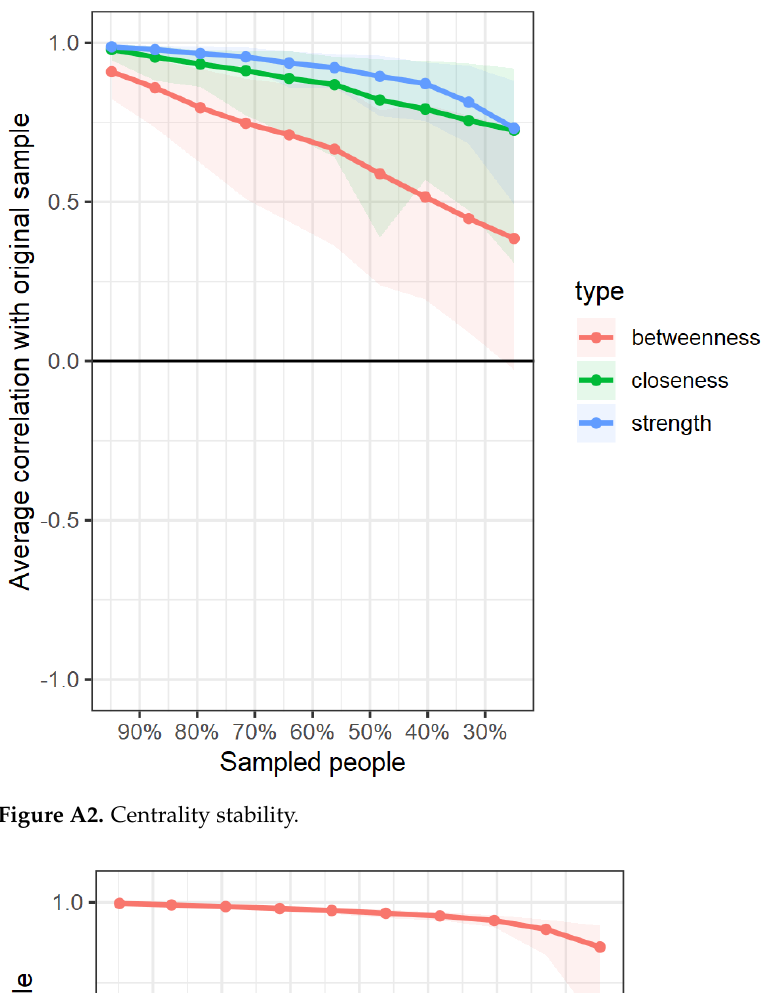
Figure A1. 95% confidence intervals for edges.